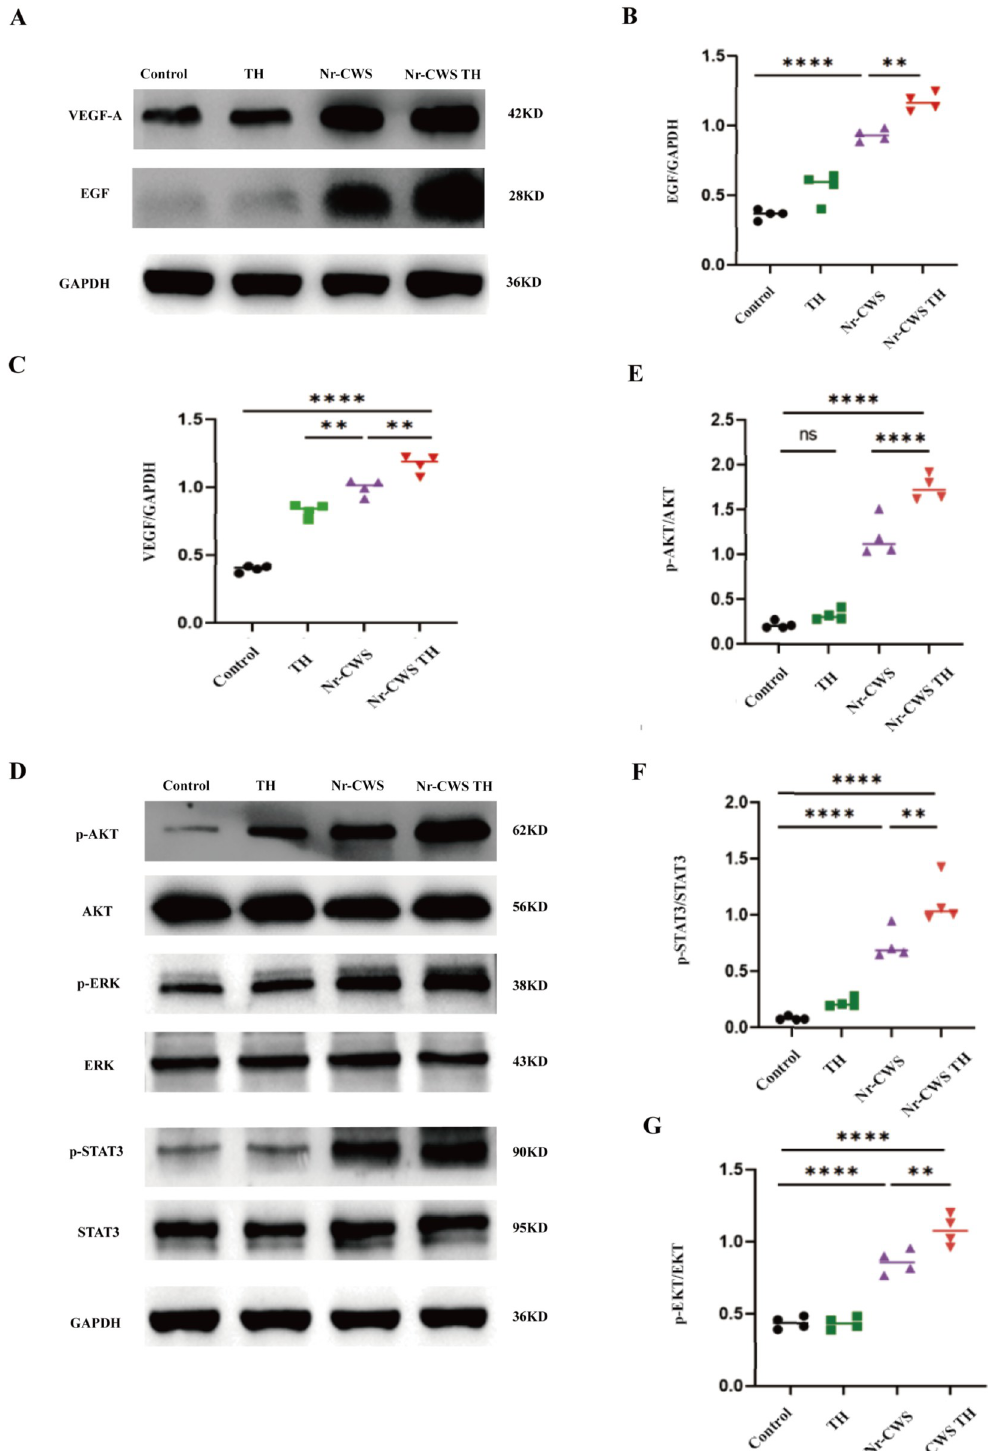
Fig 6. Nr-CWS TH treatment promote wound healing through MAPK/ERK, PI3K/AKT and JAK/STAT3 pathways. A) The protein levels of VEGF and EGF at 14 days by western blotting, GAPDH served as protein loading control); B, C) The statistical analysis of VEGF and EGF. The data are expressed in mean ± SEM, n = 4 for each group. � p < 0.05, �� p < 0.01, ��� p < 0.001, ���� p < 0.0001. D) Immunoblot for p-AKT, p-ERK, p-STAT3; the proteins amount of AKT, ERK, STAT3